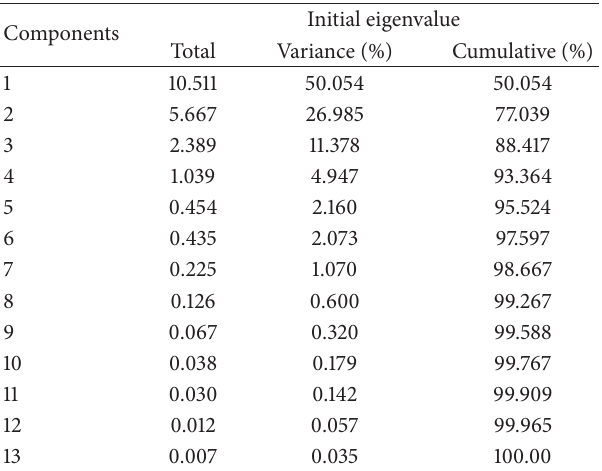
Table 4: Total variance of